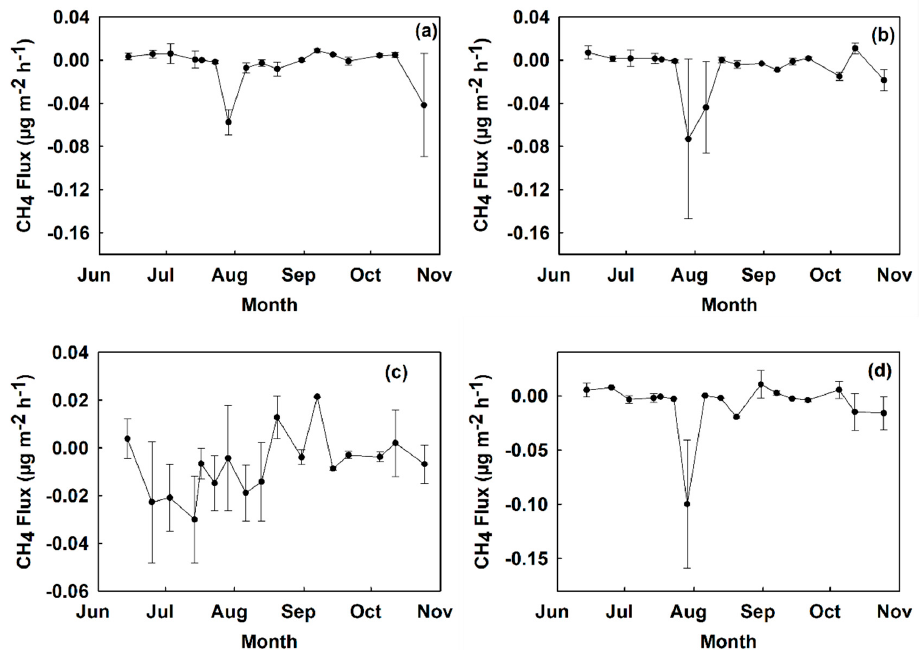
Figure 6. Time series CH 4 fluxes measured from June to October 2018 at site A in μ g CH 4 m − 2 h − 1 by treatment: ( a ) control, ( b ) digestate, ( c ) hydrochar, and ( d ) urea. Values show a mean across two replicated plots with error bars representing the standard error.